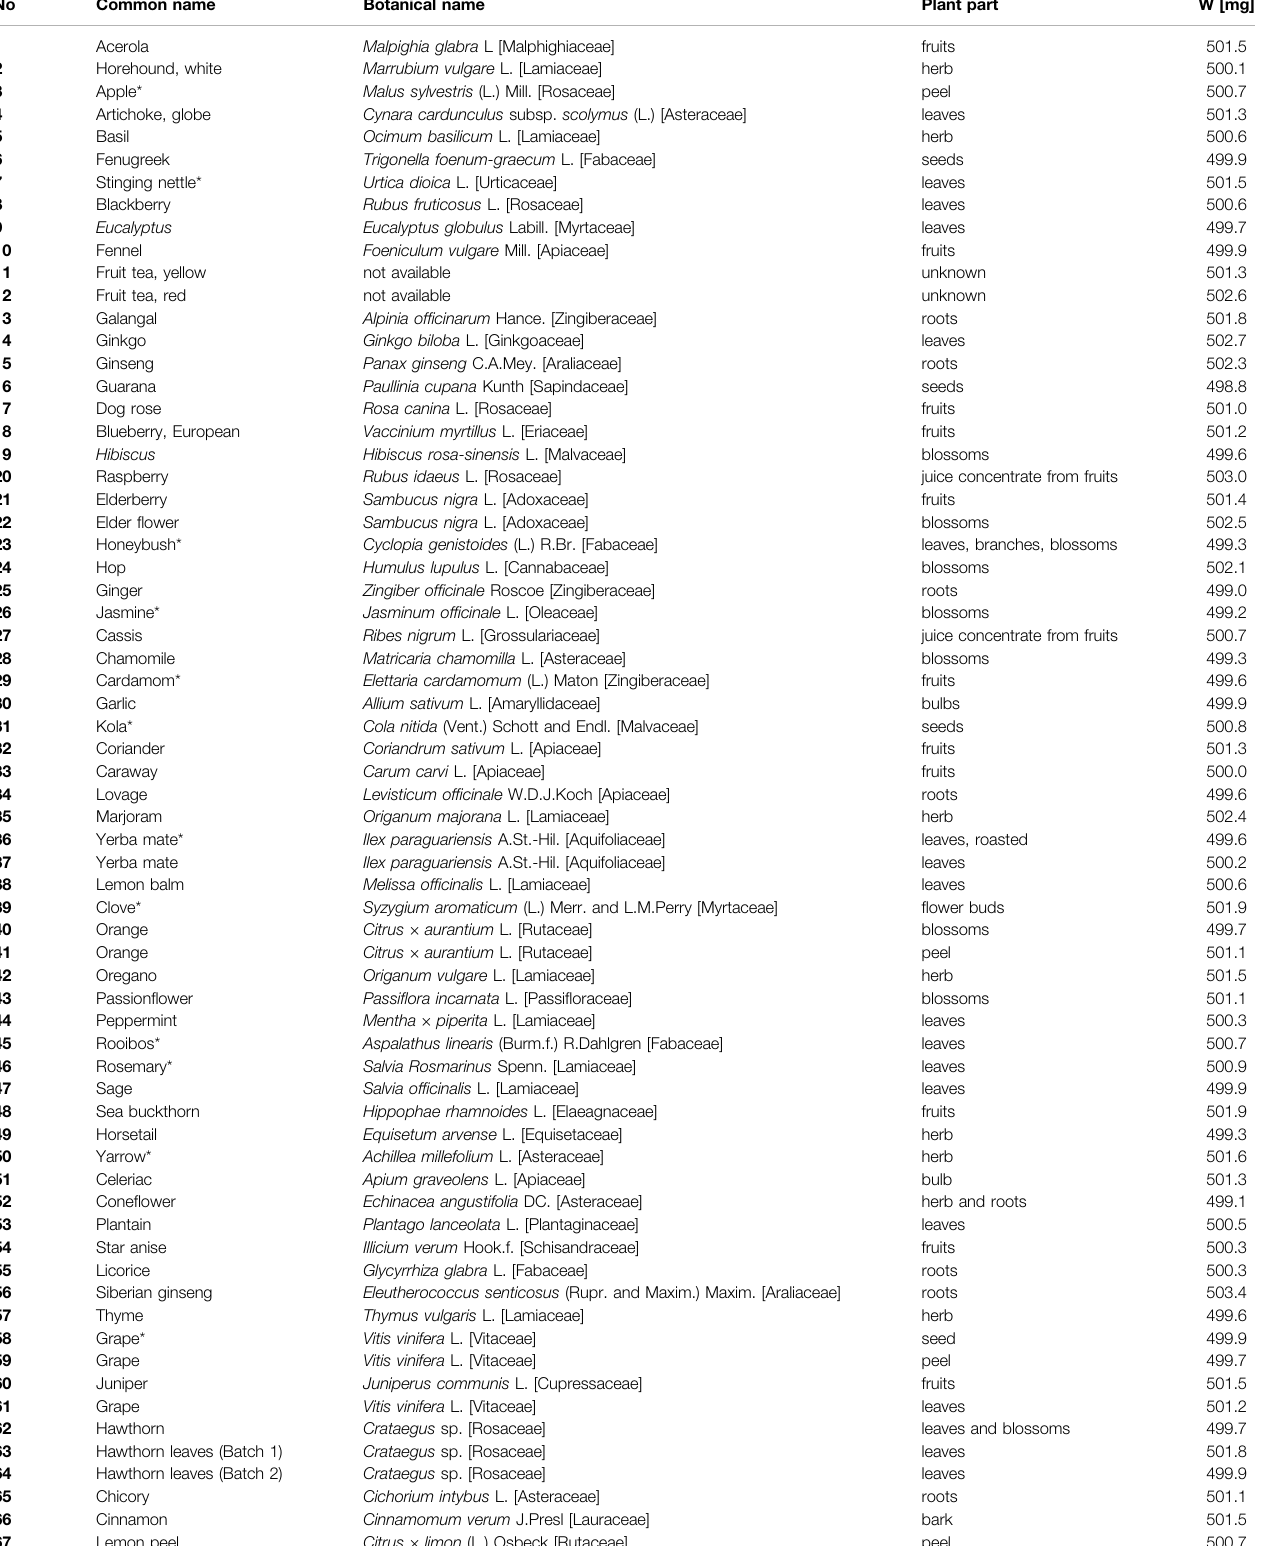
TABLE 1 | Compilation of 68 botanicals, including botanical name, plant part, and sample weights (W) extracted with 5 ml methanol (* fi ltered through 0.45 µm PTFE fi